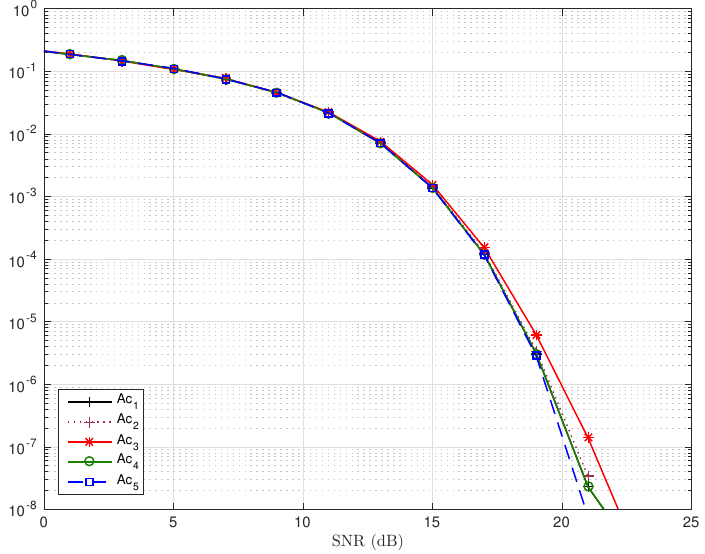
Figure 12. BER vs. SNR comparison of the proposed SC-FDM communication system among each of the couplings with N p = 16, FFT = 256, 64 QAM and BW = 200 kHz.